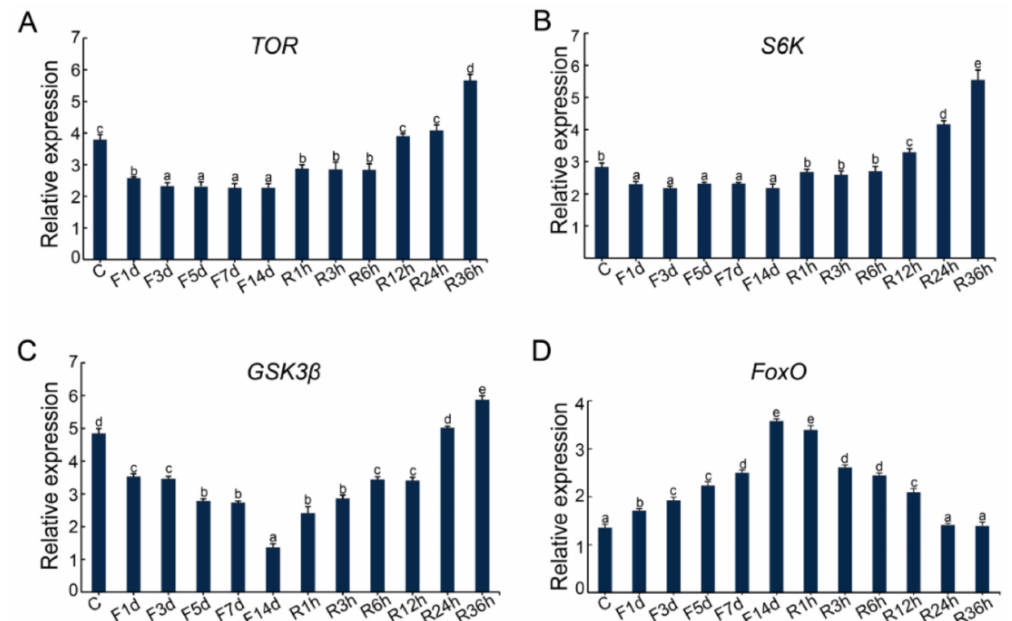
Figure 7. Effects of fasting and re-feeding on the expression of genes in the PI3K-AKT, RAS-MAPK, and TOR signaling pathways. C represents the control group; F1d, F3d, F5d, F7d, and F14d represent 1, 3, 5, 7, and 14 days after fasting, respectively; R1h, R3h, R6h, R12h, R24h, and R36h represent 1, 3, 6, 12, 24, and 36 h after re-feeding, respectively. ( A ) Effects of fasting and re-feeding on the expression of TOR . ( B ) Effects of fasting and re-feeding on the expression of S6K . ( C ) Effects of fasting and re-feeding on the expression of GSK3 β . ( D ) Effects of fasting and re-feeding on the expression of FoxO . Data are expressed as the mean ± SD (n = 3). Significant differences ( p < 0.05) among the timepoints of fasting and re-feeding are indicated by the values with different letters. At all timepoints, the lowercase letter “a” represents the lowest expression level, and is significantly different from “b”, as well as other lowercase letters such as “c”, “d”,